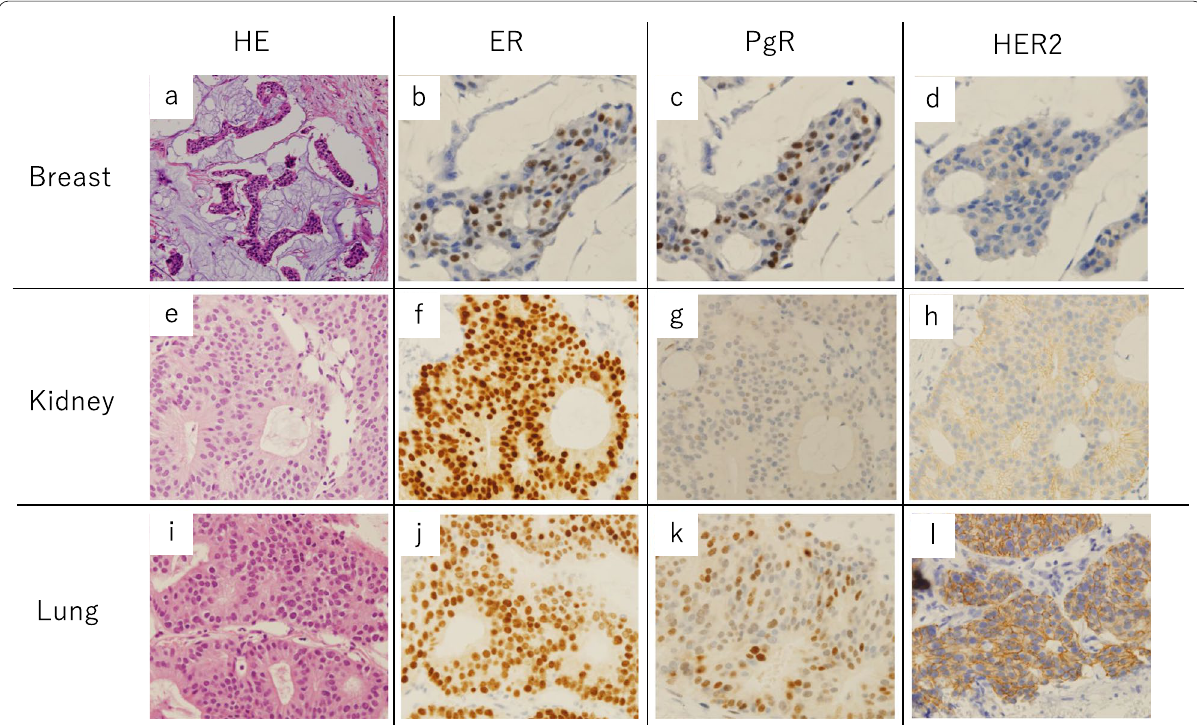
Fig. 2 Pathological findings. Almost of all breast cancer lesions had intraductal cribriform structures. There was small invasive lesions with mucus representing stromal infiltration ( a , HE 200). ER positive ( b ), PgR positive ( c ) and HER2 negative (1 × with ductal and cribriform structures, and the tumor cells are similar to those of breast cancer ( e , HE HER2 negative (2 , FISH negative) ( h ) for renal tumor. Cells in lung tumor were also similar to those of breast cancer ( i , HE + positive ( k ) and HER2 negative (2 , FISH negative) ( l ) for lung tumor. Both TTF-1 and Napsin-A were negative (not +